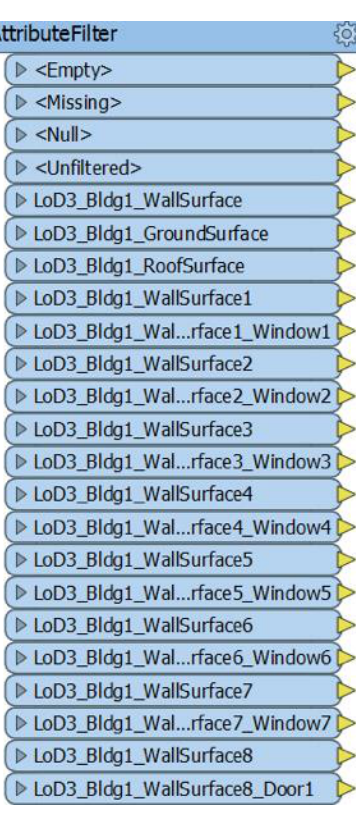
Figure 5: The AttributeFilter Transformer